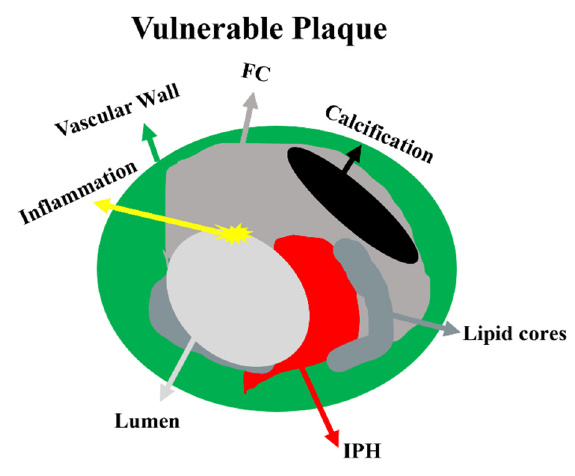
Figure 1. Schematic representation of vulnerable plaque components. Atherosclerotic stenosis is always an eccentric vascular lumen. Vulnerable plaque contains a large lipid-rich necrotic core, IPH, a thin or ruptured FC, or an inflammatory component. However, stable plaques are predominantly fibrous, with small or no lipid cores, few signs of inflammation, and thick continuous fibrous caps. Abbreviations: FC— fi brous cap; IPH—intraplaque hemorrhage.